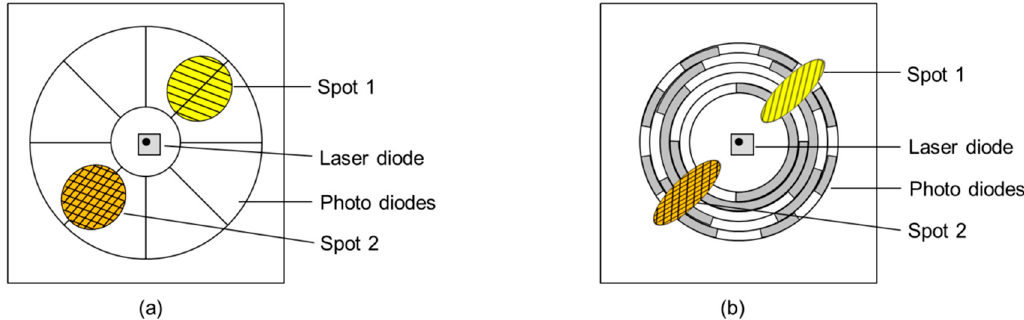
Figure 5. Two different layouts for the photodetector of the optical encoder. ( a ) Segmented arrangement of the photodiodes; ( b ) Gray code arrangement of the photodiodes.